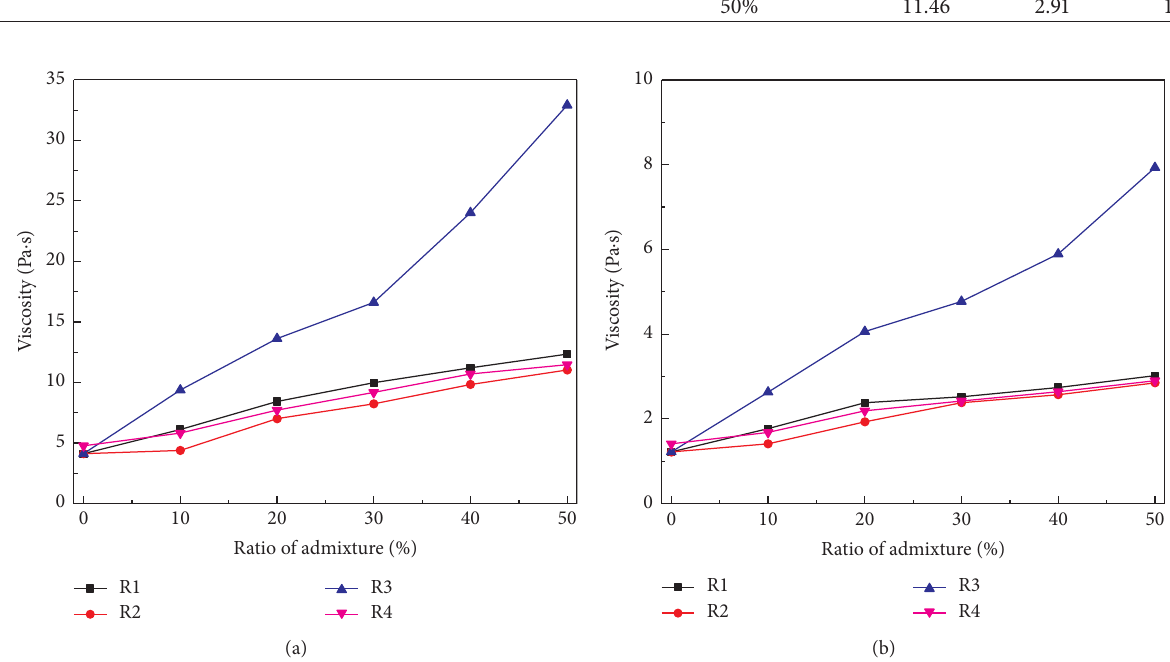
Figure 6: Viscosity variation along different ratios of admixture at (a) the temperature of 90 ° C and (b) the temperature of 110 °